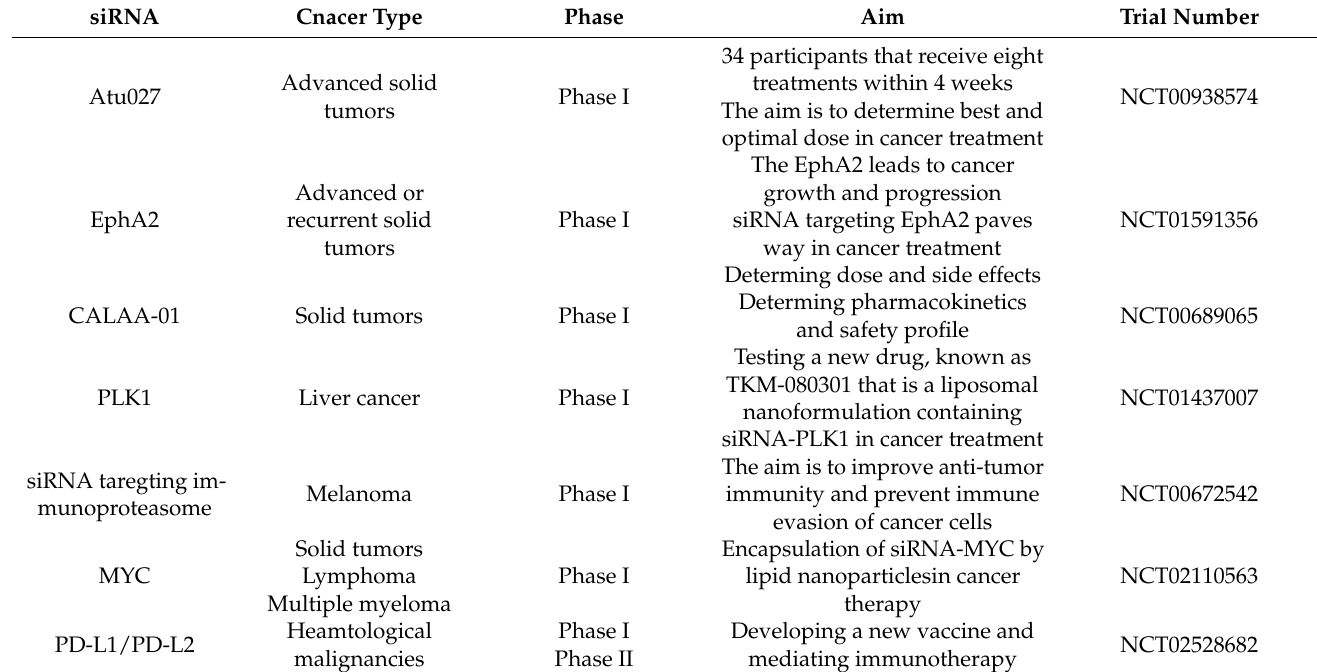
Table 1. Clinical trials using siRNAs in the treatment of cancer